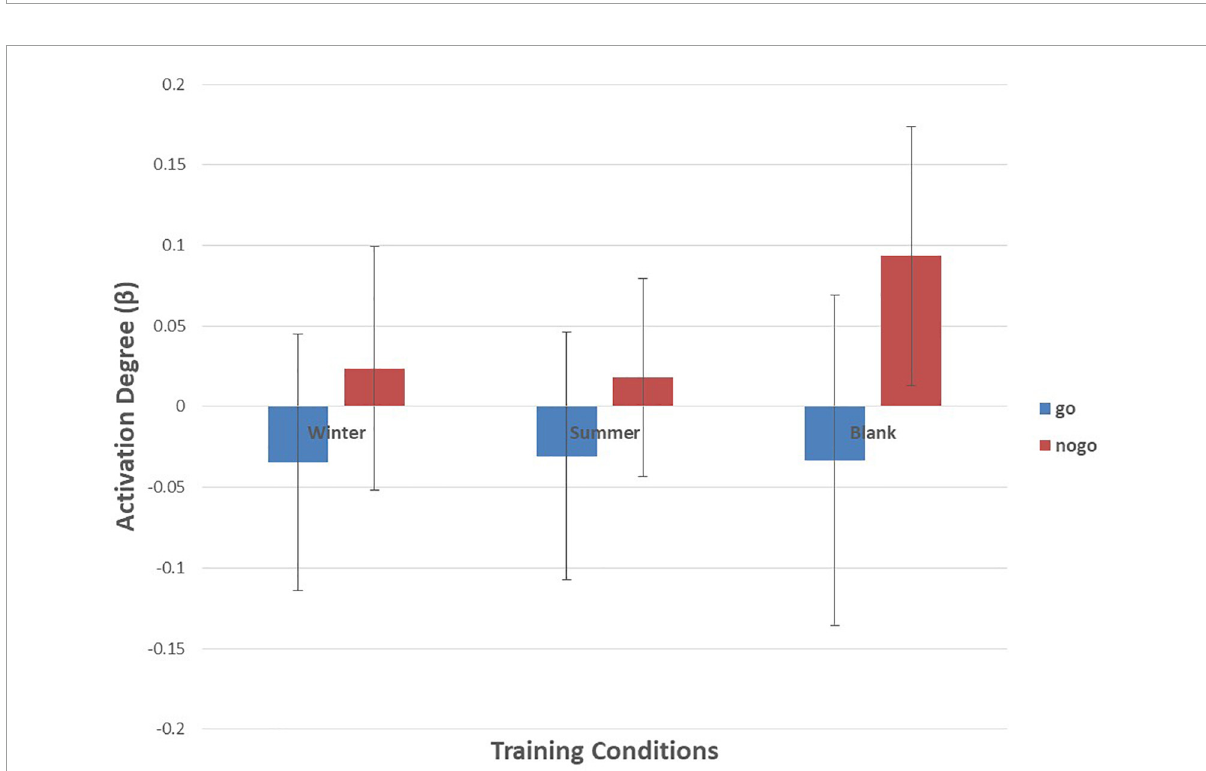
FIGURE9 Means of activation degree ( β ) of ch22 of go tasks and nogo tasks in three training conditions. Error bars represent the standard